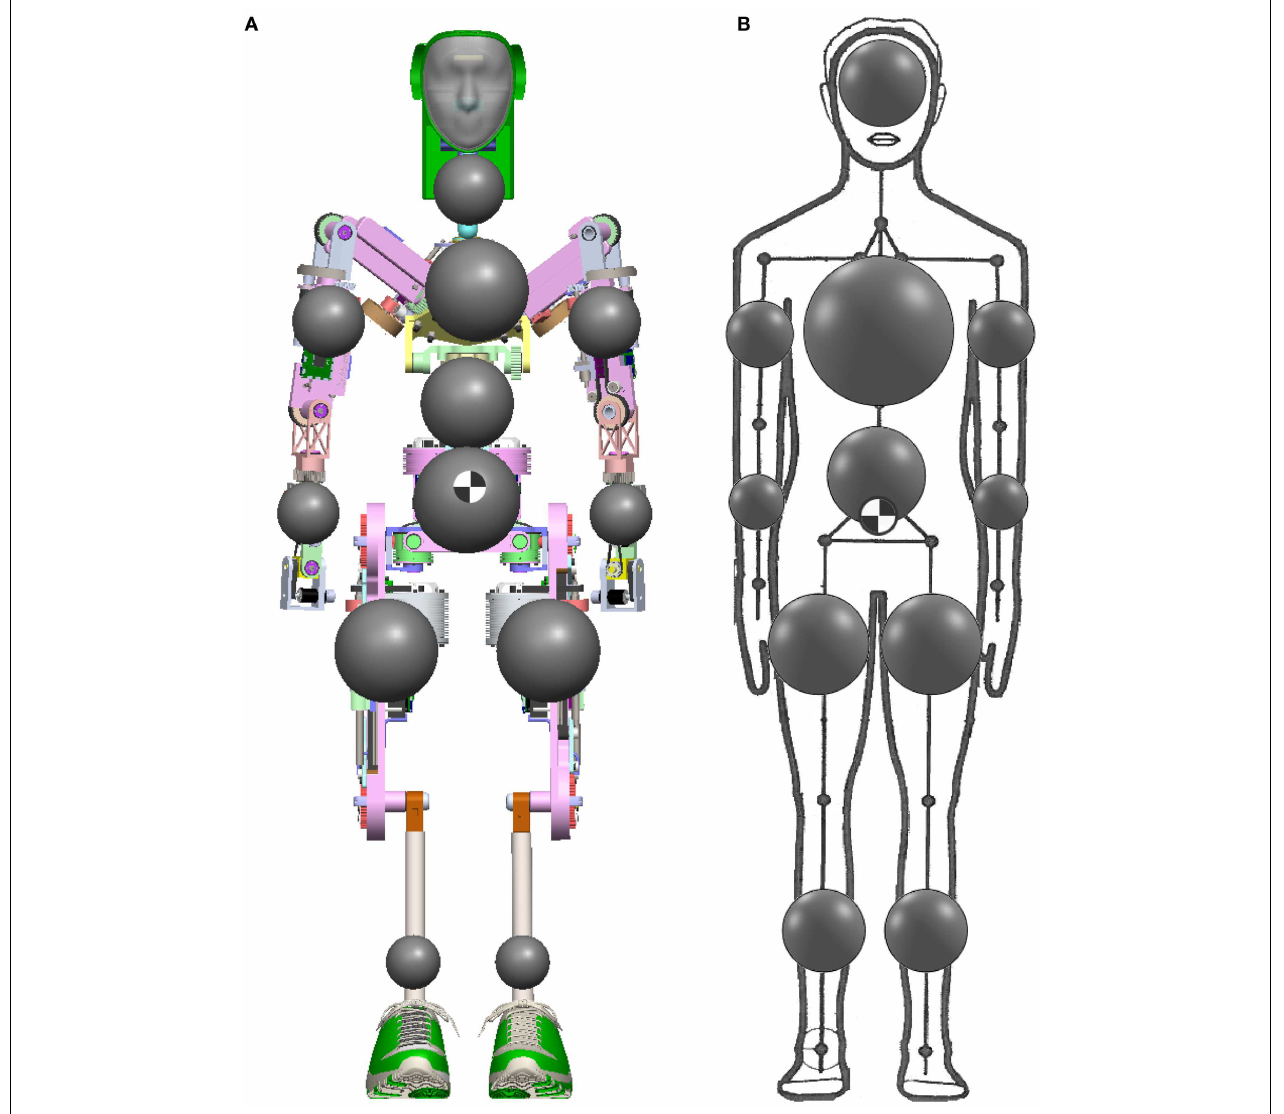
FIGURE 3 | (A) The mass distribution of Herbert where the volume of the dark spheres are proportional to the mass. (B) The mass distribution of a